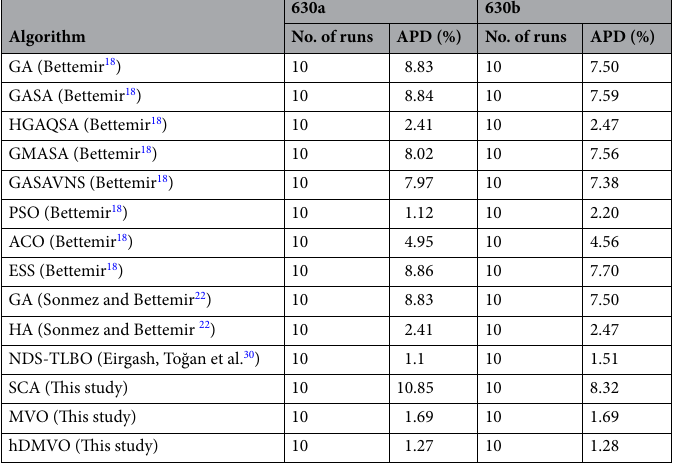
Table 14. Average percent deviation from the optimal for problem 630a and